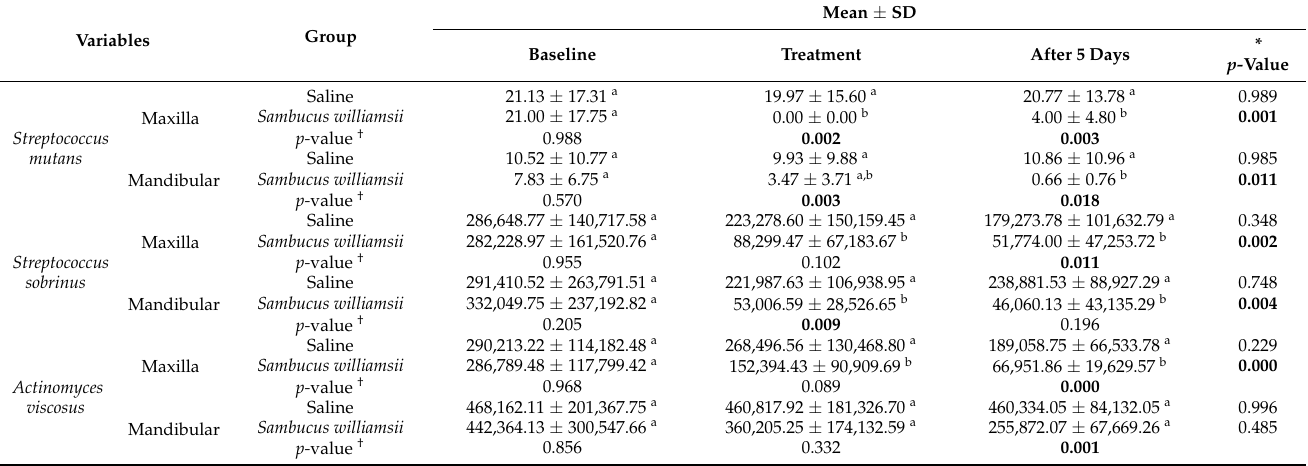
Table 4. Clinical outcomes of two